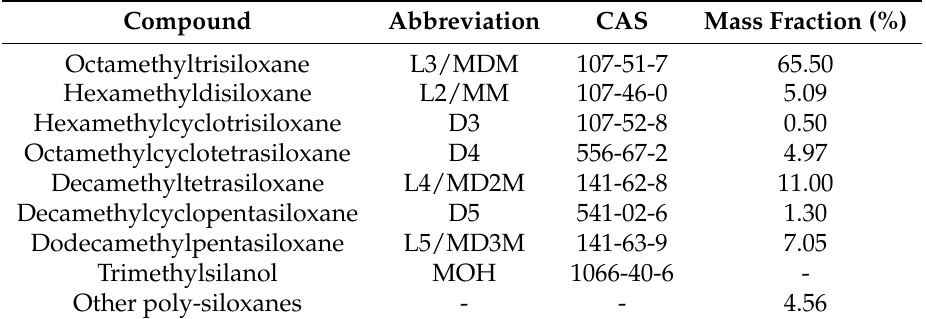
Table 4. HS-GC-MS analysis results of cycle fluid (source: recuperator reservoir)